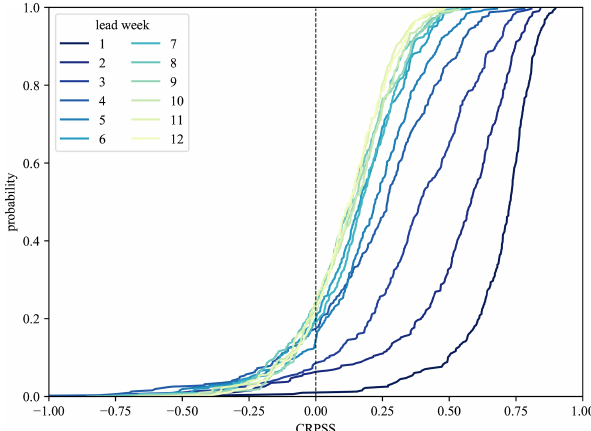
Figure 2. CDFs of weekly CRPSS shown for different lead weeks, with CRPSS being aggregated over all models and stations for dis- charge hindcasts. CRPSS is decreasing with increasing lead weeks, but even up to 12 weeks, roughly 60% of all stations and models show a better performance than the reference